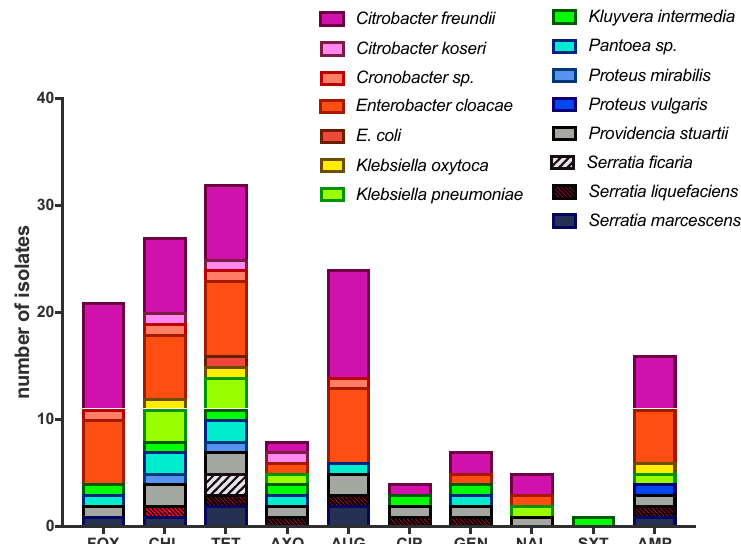
Figure 2. Antimicrobial resistant (AMR) isolates from house flies collected at the agricultural site (dairy farm). Antimicrobial sensitivity testing was performed using the MIC method (details in text) on the Sensitre® Gram negative NARMS plate. Antimicrobial abbreviations: FOX, cefoxitin; CHL, chloramphenicol; TET, tetracycline; AXO, ceftriaxone; AUG, amoxicillin/clavulanic acid (2:1); CIP, ciprofloxacin; GEN, gentamicin; NAL, CIP, Ciprofloxacin, NAL, nalidixic, SXT, trimethoprim-sulfamethoxazole; AMP, ampicillin. MIC values for all isolates and additional antimicrobials are presented in Table S1.